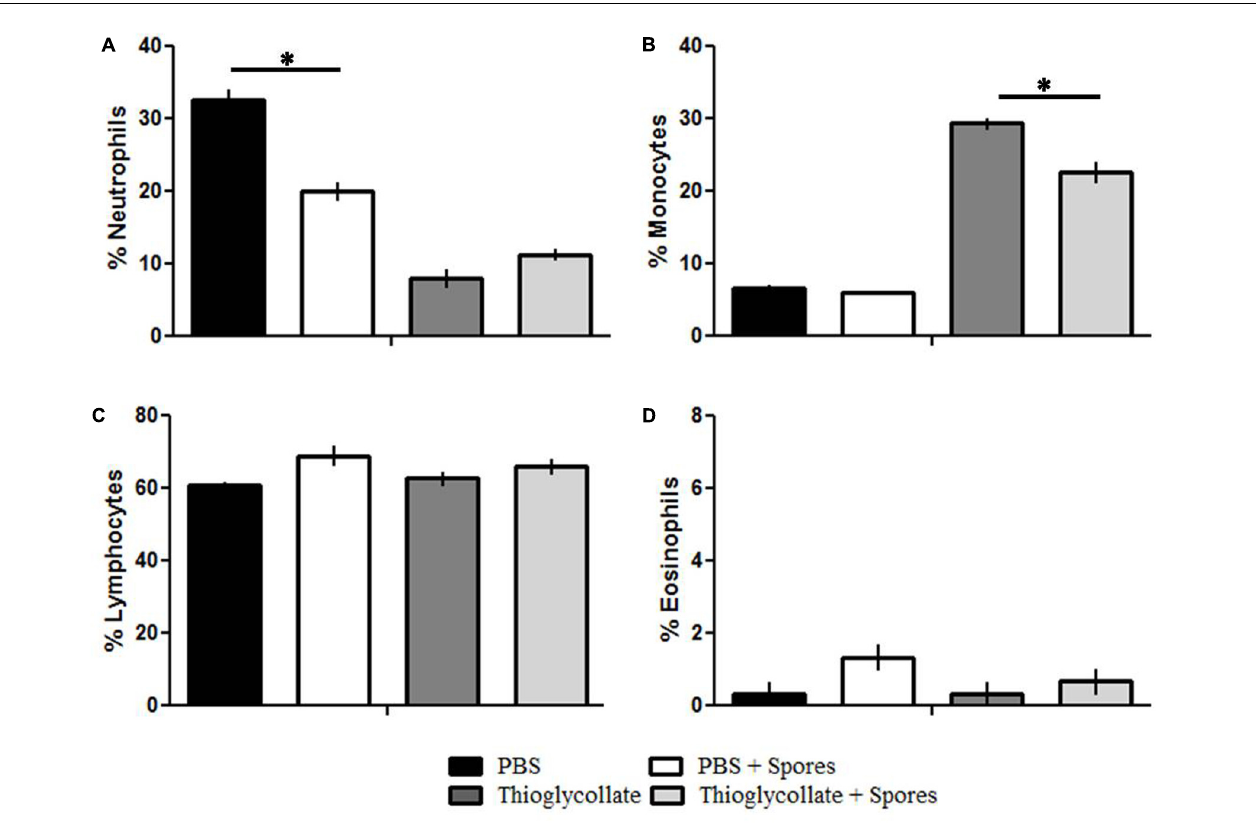
FIGURE 1 | Differential count of peripheral blood leucocytes. C57BL/6 mice were treated with PBS, PBS + spore, thioglycollate and thioglycollate + spore and the differential count of peripheral blood lymphocytes were evaluated. (A) Neutrophils, (B) Monocytes, (C) Lymphocytes, (D) Eosinophil. Data represents mean ± SD of three independent experiments with three mice per group. ∗ p ≤